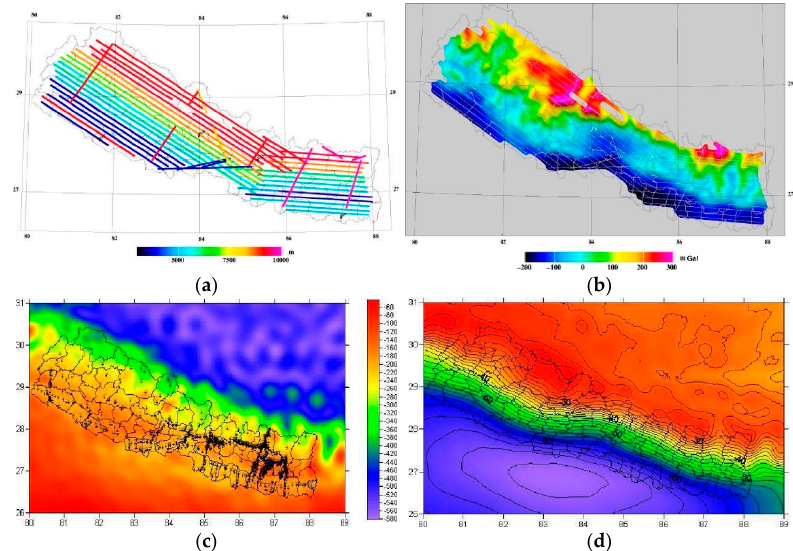
Figure 15. Results from airborne gravity survey 2010: ( a ) flight elevations, ( b ) free air anomaly (FAA) at flight elevation, ( c ) Bouguer anomaly and surface gravity stations (unit: mgal), ( d ) geoid of Nepal (unit: meter) [49,50].